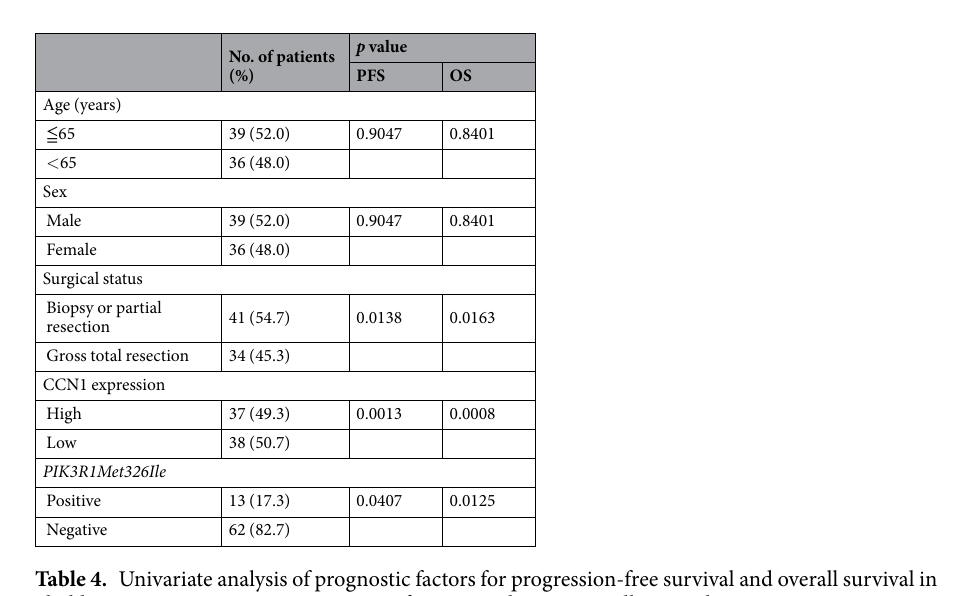
Figure 4. Kaplan-Meier survival curves for patients with and without PIK3R1Met326Ile mutations. ( A ) Progression-free survival of patients with PIK3R1Met326Ile was significantly shorter than that of patients without PIK3R1Met326Ile ( p = 0.0407). ( B ) Overall survival of patients with PIK3R1Met326Ile was significantly shorter than that of patients without PIK3R1Met326Ile ( p = 0.0125).